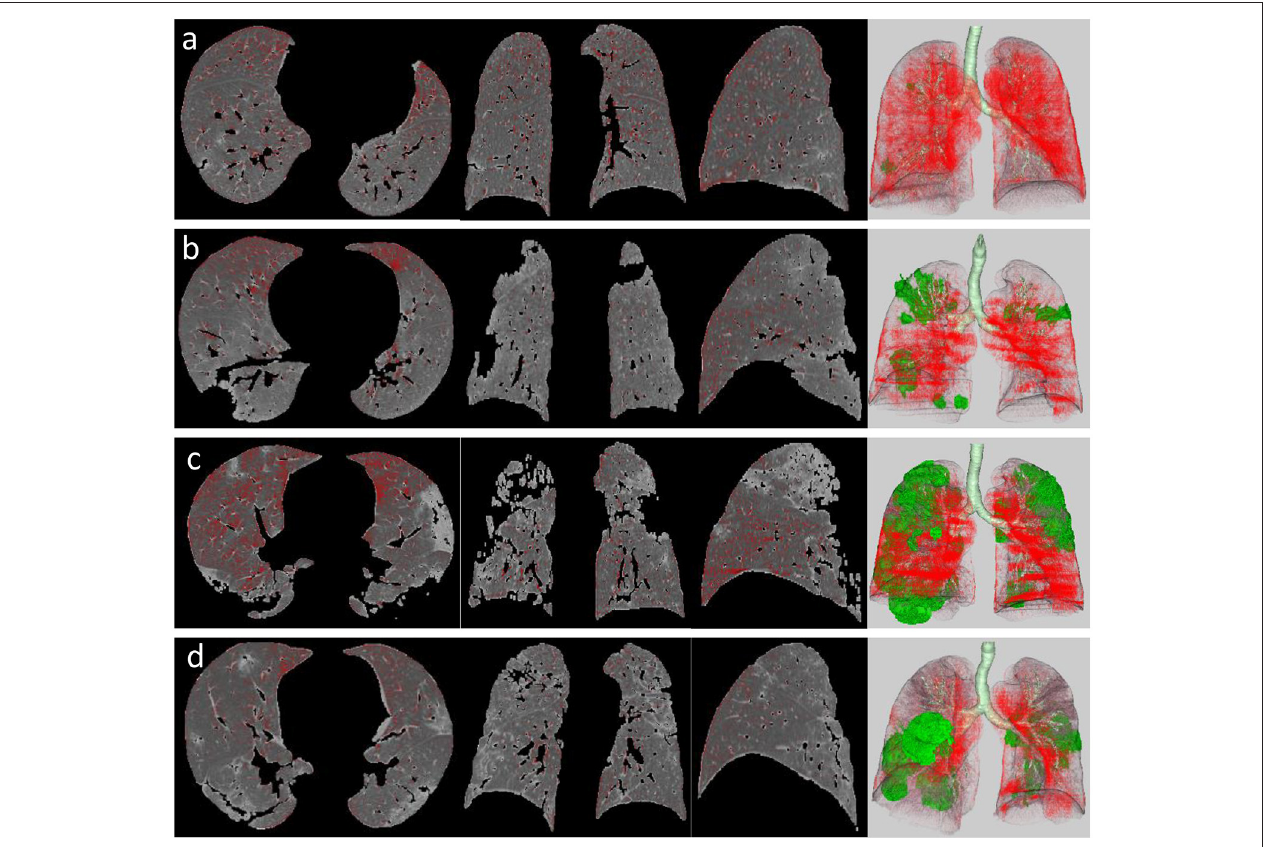
FIGURE 3 | LAA views of the four stages in a patient with COVID-19 pneumonia, which was defined as the lung field area with attenuation values < -950 HU of threshold (red areas). It shows axial, coronal, and sagittal two-dimensional (2D) displays and three-dimensional (3D) image (left to right) of LAA distribution in the early stage (a) , progressive stage (b) , peak stage (c) , and absorption stage (d) . Green area on 3D image represents pneumonia